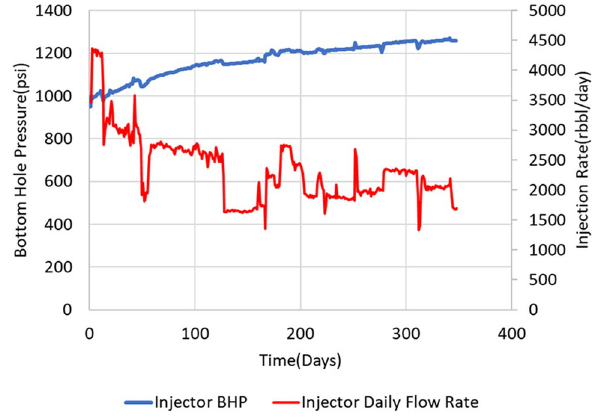
Fig. 8 BHP and CO 2 injection rate for injection well in south